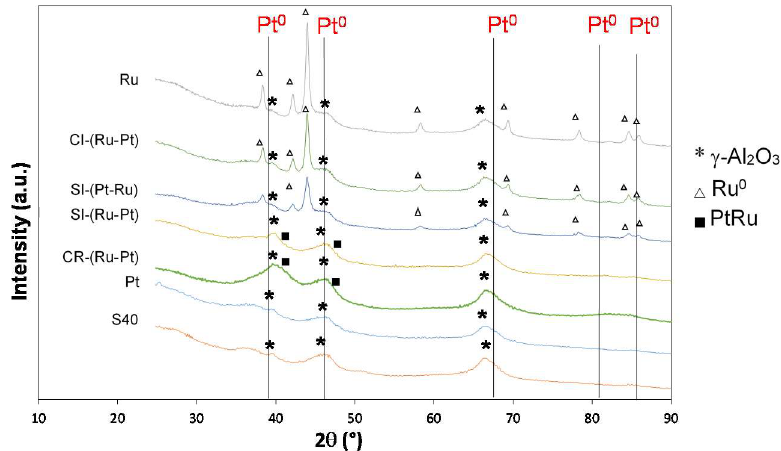
Figure 2. XRD patterns of the Ru–Pt/S40 bimetallic catalysts, according to their preparation method: co-impregnation (CI), successive impregnations (SI) or catalytic reduction deposition (CR) (the diffractograms of the lone support (S40), Pt/S40 and Ru/S40 monometallic catalysts are also given for comparison).